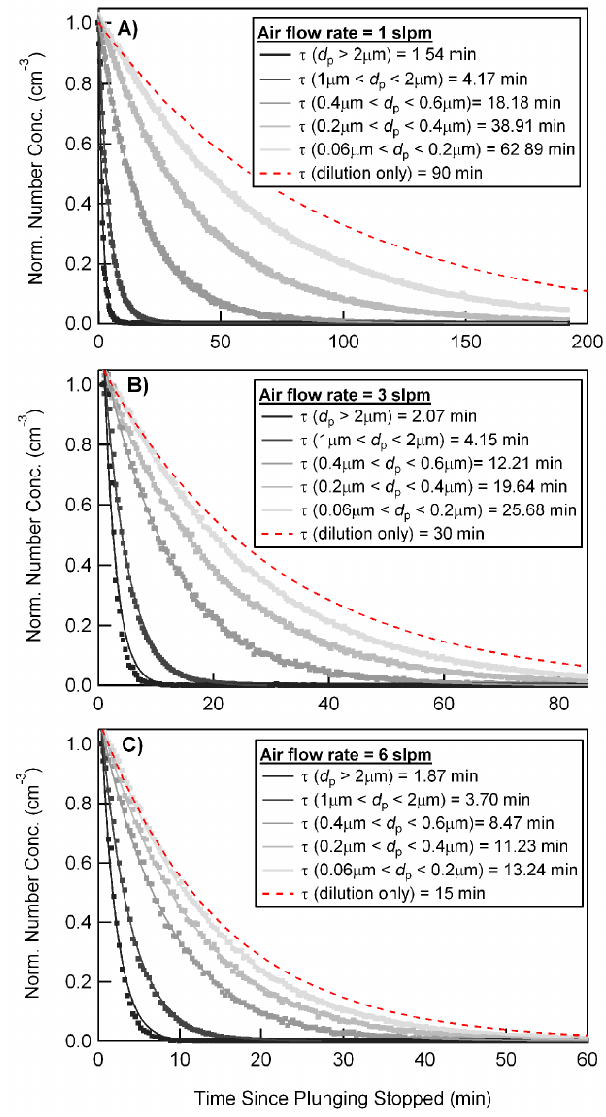
Fig. 6. Normalized size dependent decay rates in particle number concentration (cm − 3 ) for three different dilution air flow condi- tions: 1slpm (A) , 3slpm (B) , and 6slpm (C) as measured following the suspension of in tank plunging. The associated e-folding life- times ( τ) for each flow condition and size regime are included in the legend alongside the expected decay rates from dilution